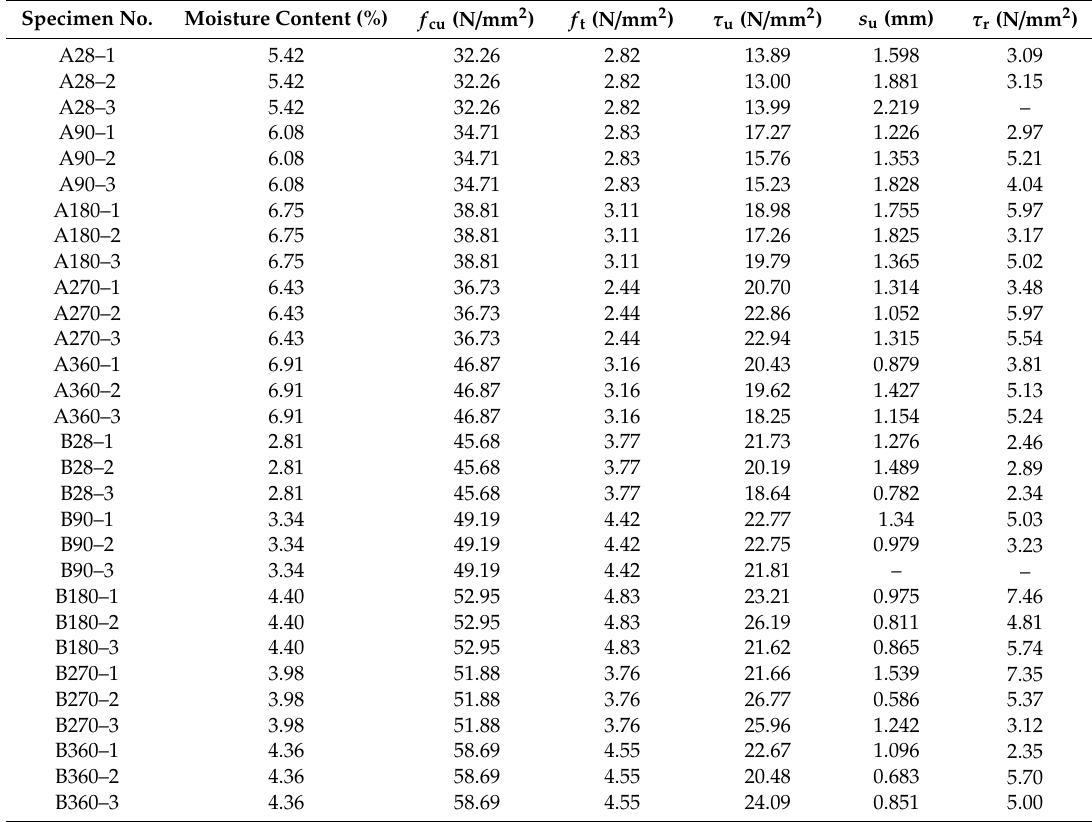
Table A1. Summary of tested values of key points at the bond–slip curves. Specimen